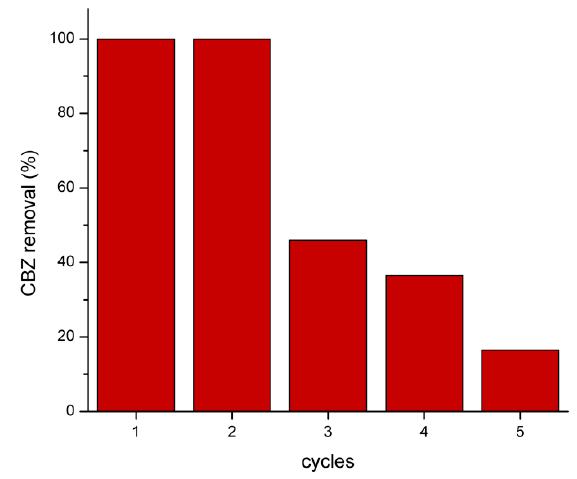
Figure 4. CBZ degradation in the presence of Fe 3 O 4 -LHA and H 2 O 2 after several 10 min-cycles of UV irradiation. (CBZ) 0 = 2 mg L − 1 ; (Fe 3 O 4 /LHA) 0 = 500 mg L − 1 ; (H 2 O 2 ) 0 = 0.15 mM, pH = 3.0.